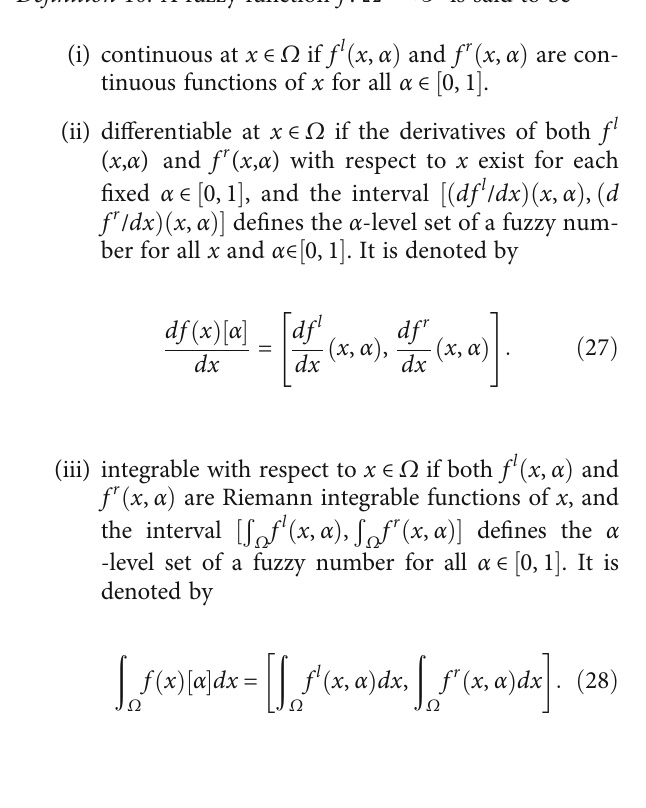
Figure 7: Graphical illustration of the α -level sets of ~ A